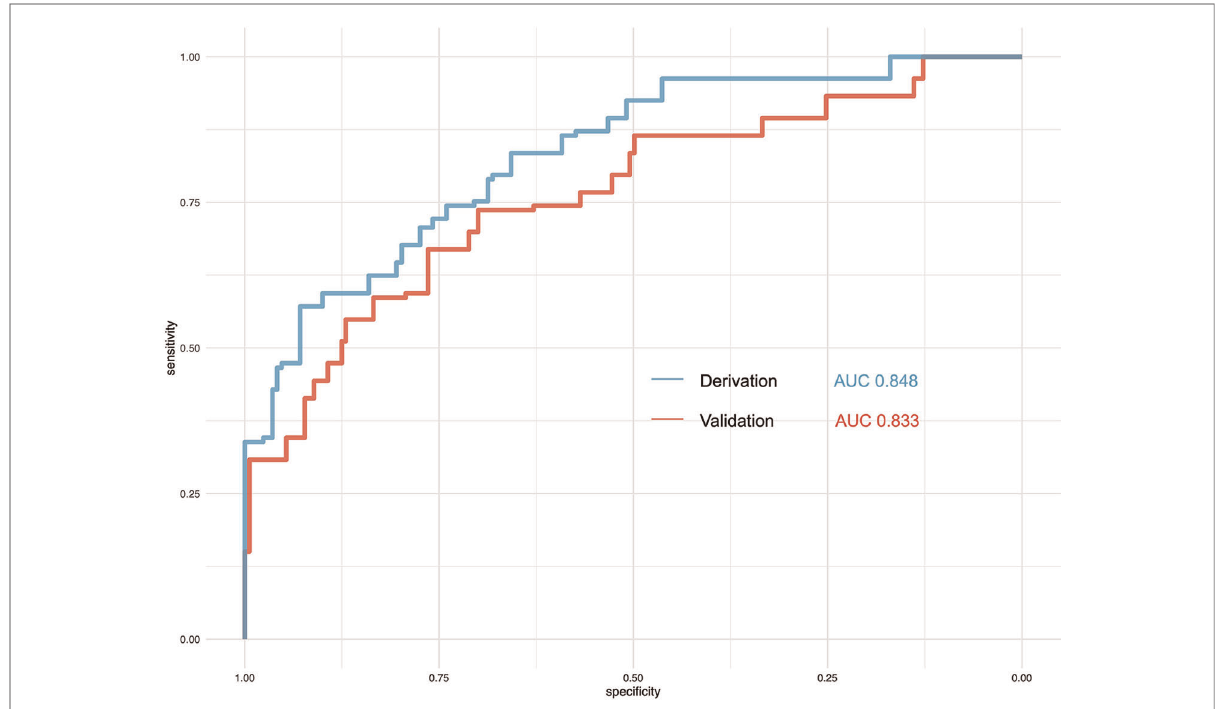
FIGURE 3 Comparison of the performance of the prediction model in the derivation and validation cohorts. AUC, area under the curve.